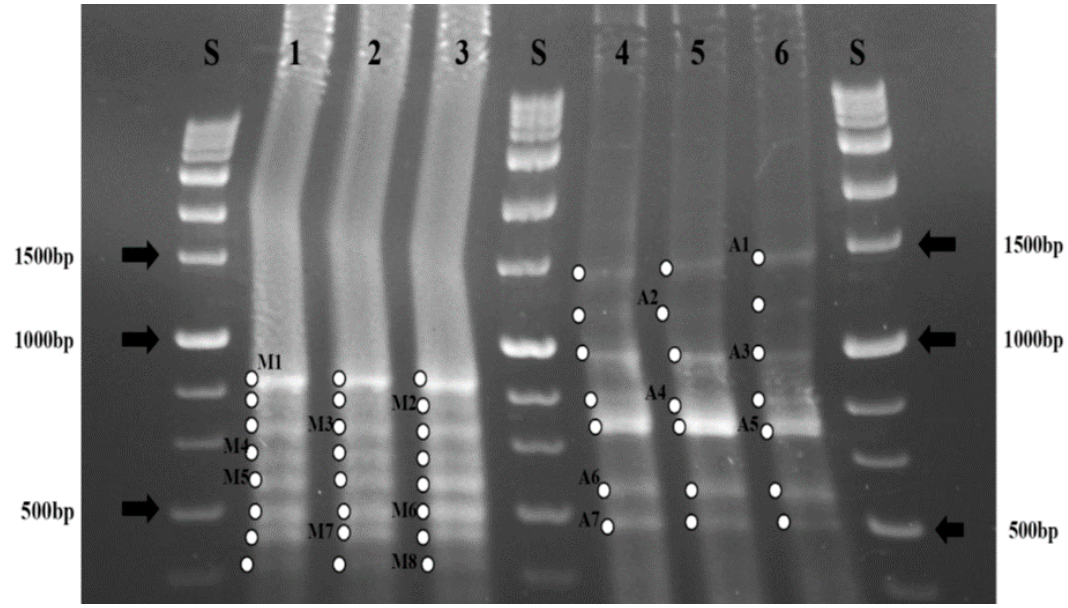
Figure 9. RFLP pattern analysis of bacterial 16S rRNA gene digested with MspI ; Lane 1 = MBR1; Lane 2 = MBR2; Lane 3 = MBR3 in the aerobic membrane reactor; Lane 4 = MBR1; Lanes 5 = MBR2; Lane 6 = MBR3 in the anoxic activated sludge reactor.